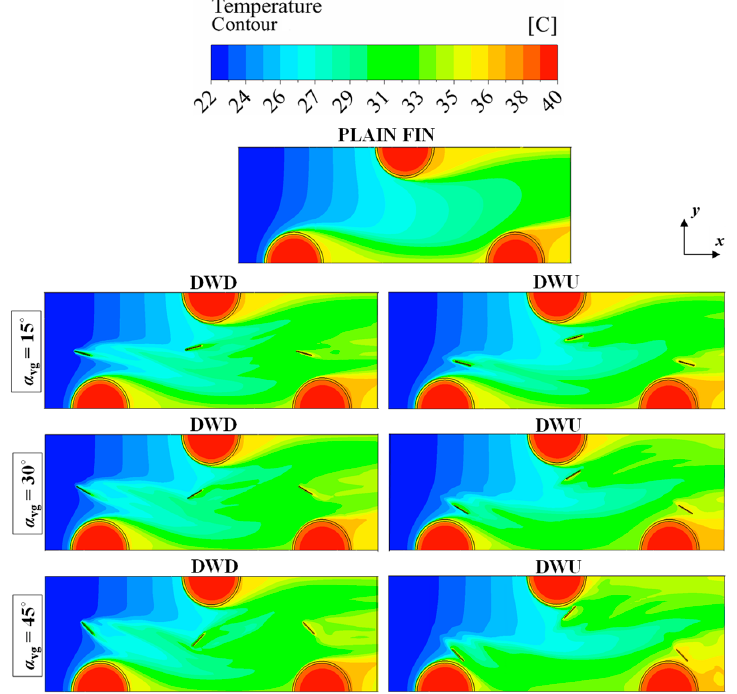
Figure 14. Temperature distributions at central plane z = 1.405 mm for air − to − water FTHEXs with plain fins and fins with DWD and DWU types of vortex generators. Test conditions: T air,in = 22 °C, T water,in = 40 °C, w air,in = 1.03 m/s , w water,in = 0.76 m/s . In order to examine the air-side heat transfer behaviour along the airflow direction, the local distributions of the air-side heat transfer coefficient (HTC) on the fin surfaces with and without VGs for w air,in = 1.03 m/s ( Re Dh = 400) are shown in Figures 15 and 16. The surface with the VGs is the lower fin surface and the surface without VGs is the adjacent upper fin surface. The local regions of high heat transfer associated with the (I) horseshoe in the presence of delta-winglets and (III) guidance of the airflow in the wake zones visible on the air-side HTC contours. It is evident that the maximum values of the air-side HTC